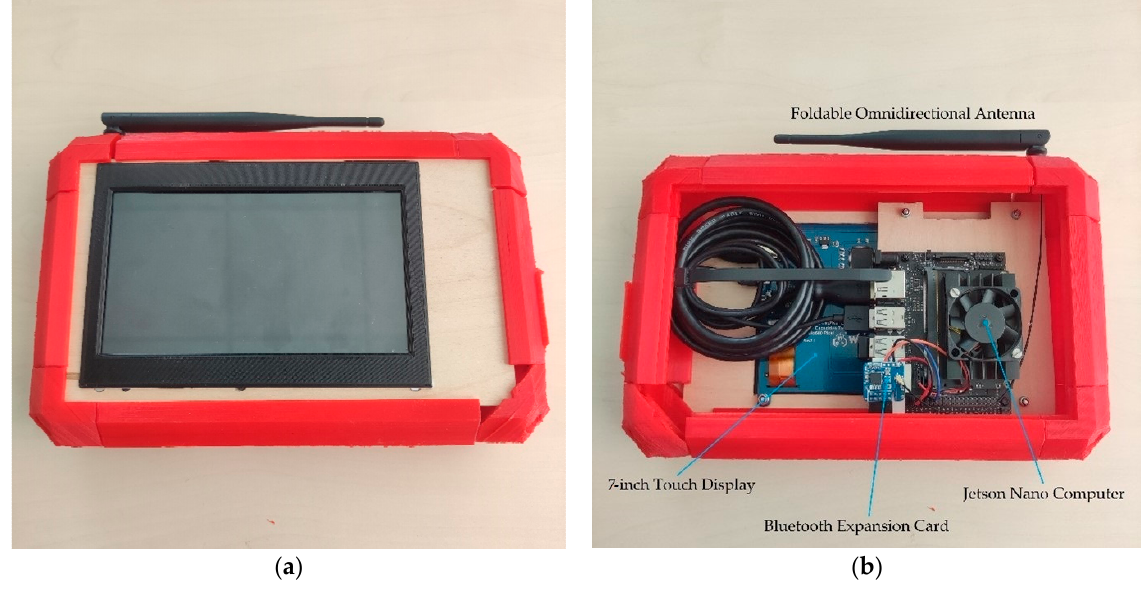
Figure 5. The appearance of prototype radio tomograph central unit designed by CBRTI Sp. z o.o. Research and Development Center: ( a ) front, ( b ) rear and interior.